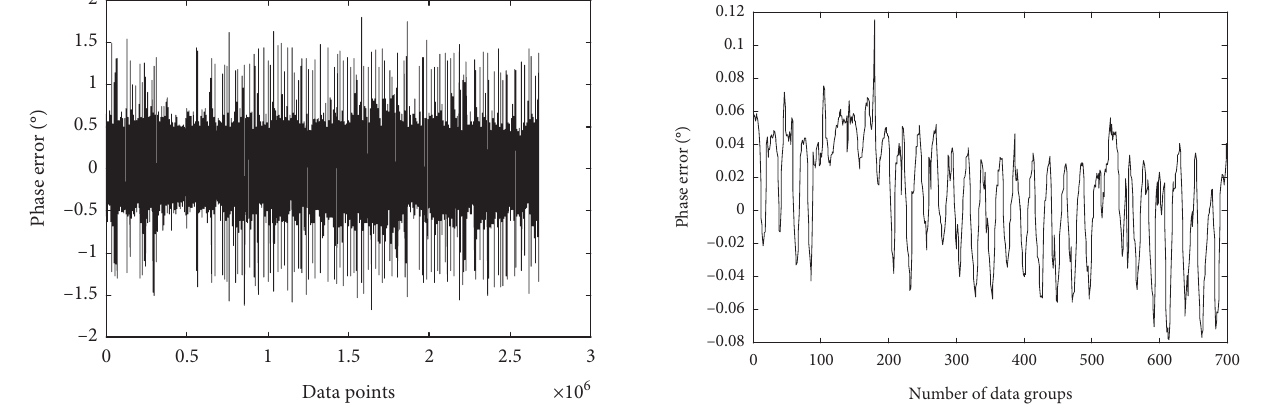
Figure 3: Original ET phase error data. Figure 4: ET phase error data after